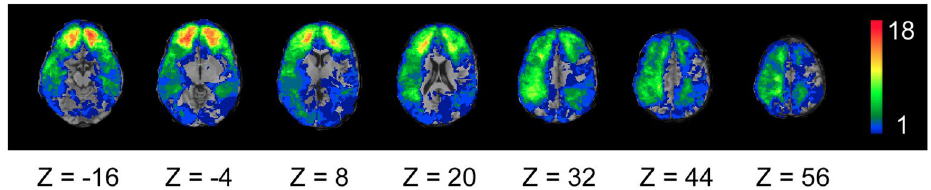
Figure 3. Overlay density map of the pTBI patients’ lesions (n = 109). The color legend indicates number of patients with damage to a particular voxel. Images are in radiological space (i.e., right is left).